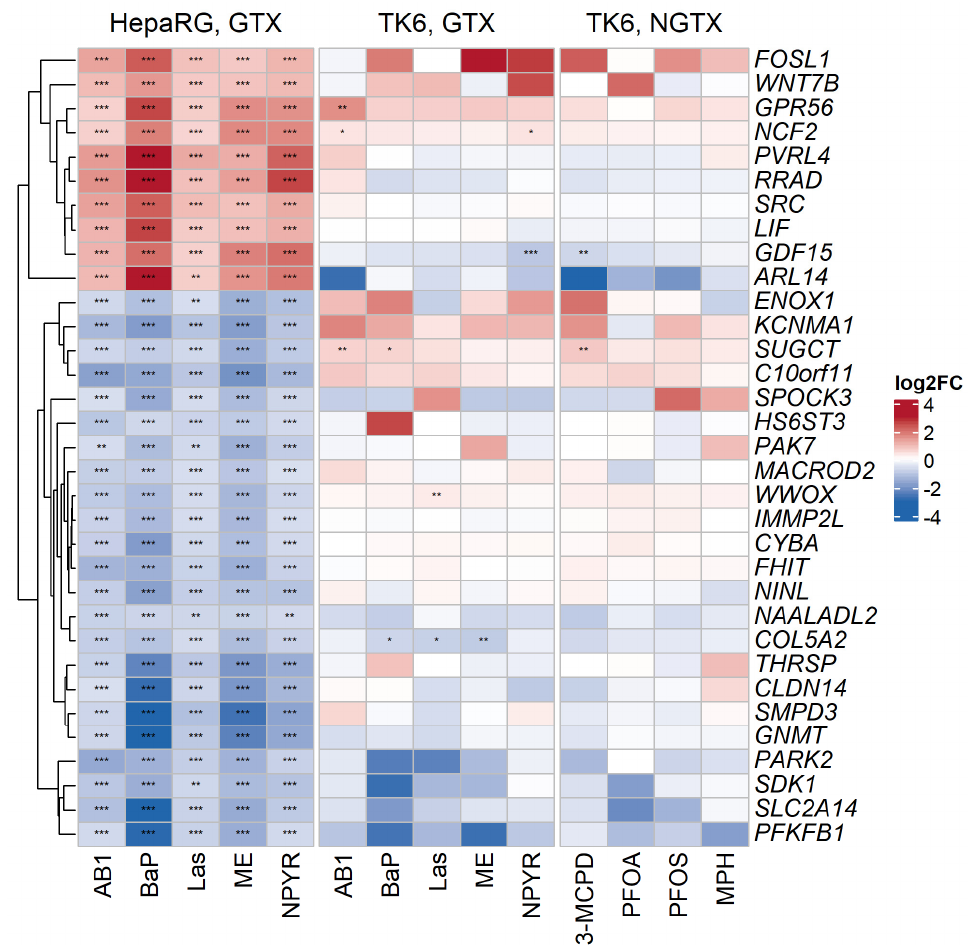
Figure 3. Comparison of the TK6 data with a published GTX effect marker pattern for genotoxicity. In Kreuzer et al. [14], a gene signature for GTX in the liver cell model HepaRG was published. There, 37 genes were identified, all significantly regulated in one direction with p adj < 0.05 and |FC| > 1.5 after treatment with GTX, of which 33 genes were chosen for further analysis. The heatmap here shows a comparison of HepaRG- and TK6-derived transcriptomic data for the 33 GTX marker genes from HepaRG cells expressed as log 2 FC values. Upregulation is depicted in red and downregulation in blue. Significance of the gene expression changes is indicated as follows: * p adj < 0.05, ** p adj < 0.01, and *** p adj < 0.001.